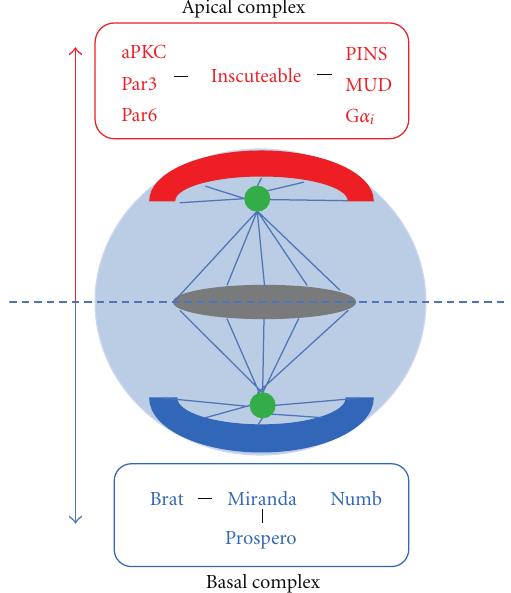
Figure 4: Asymmetric cell division in Drosophila neuroblasts. Apical (red) and basal (blue) proteins are asymmetrically segregated at cortical ends of the neuroblast at the time of mitosis. Members of the apical complex are involved in the asymmetric partitioning of basal determinants, in establishing cell polarity and in the correct orientation of the mitotic spindle. The apical complex consisting of aPKC, Par3, and Par6 is linked to the G α i-PINS-MUD complex via Inscuteable. The basal complex consists of the cell-fate determinants, Miranda, Prospero, Brat, and